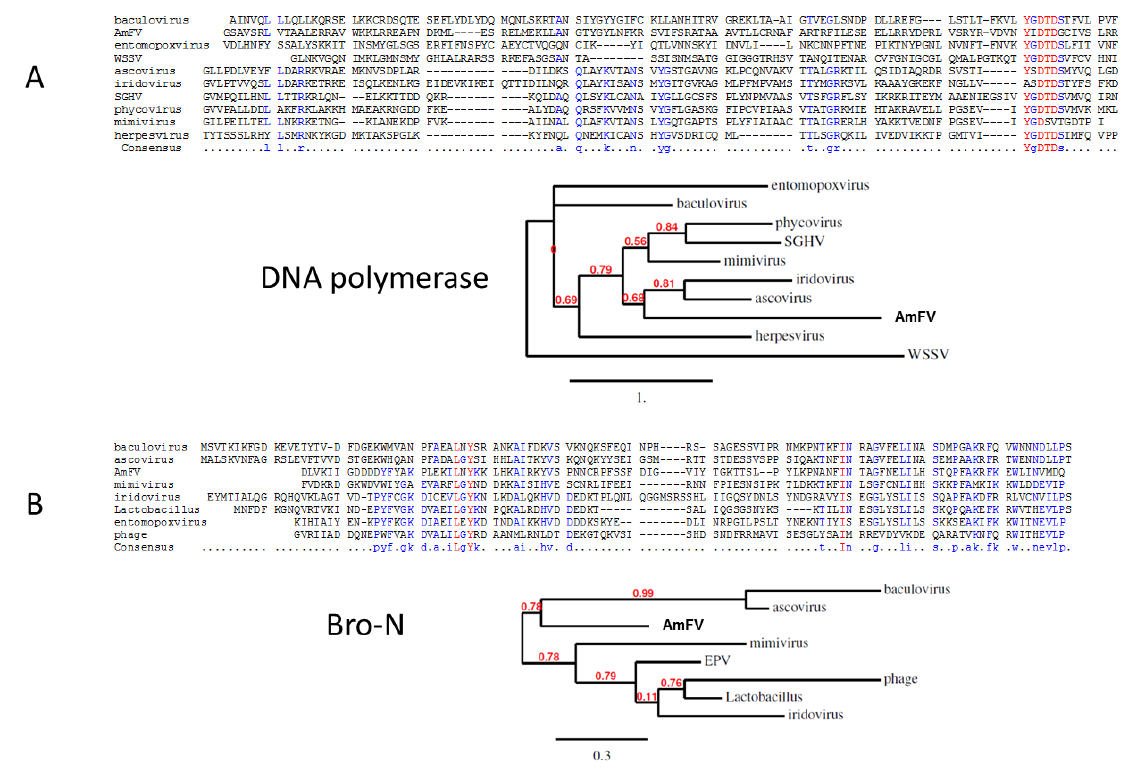
Figure 3. Multiple sequence alignments and phylogenetic trees for the DNA polymerase ( A ) and Bro-N ( B ) domains. Branch support values are indicated in red. GenBank entries from top to bottom: A, gi|365199561|, gi|1063688|, gi|409978642|, gi|589287870|, gi|9964364|, gi|15021419|, gi|187903038|, gi|312233904|, gi|2702251|, and gi|311977705|; and B, gi|15021419|, gi|325152622|, gi|21668326|, gi|55416627|, gi|9631452|, gi|672972322|, gi|736994060|, and